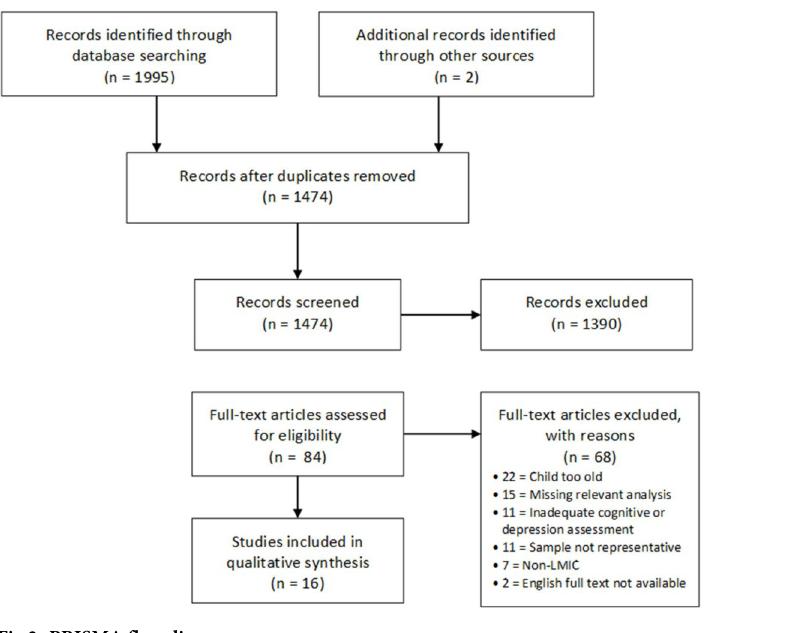
Fig 2. PRISMA flow